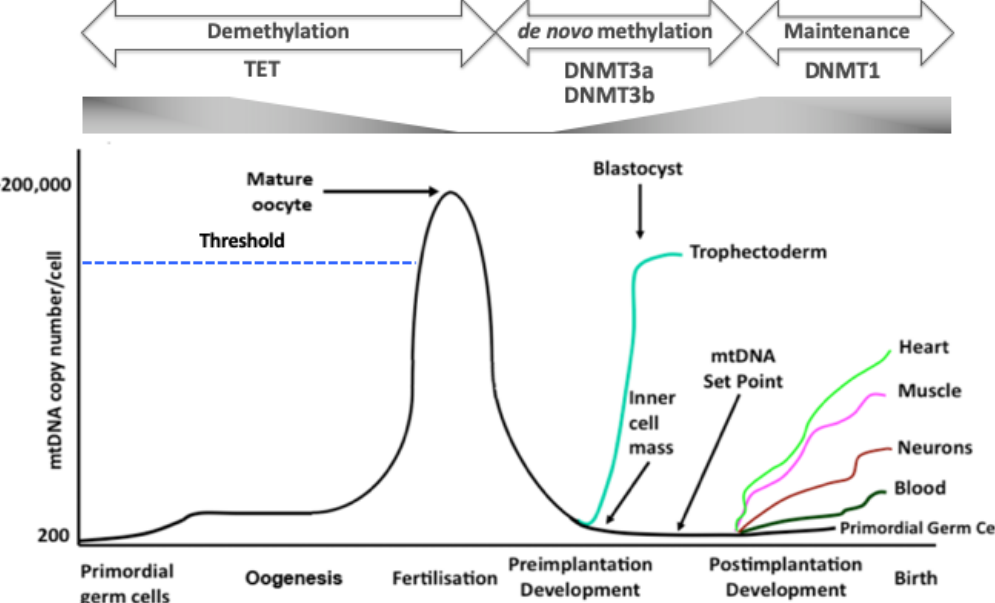
Figure 1. DNA methylation and mtDNA replication. Primordial germ cells, the very first germ